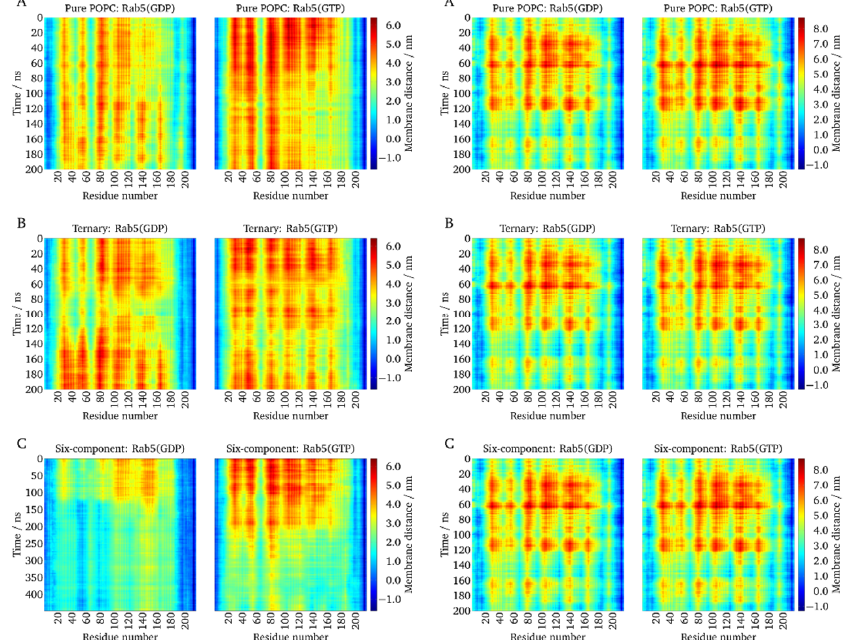
Figure 5. The z-distances between each amino acid residue and the membrane surface were monitored over the molecular dynamics (MD) trajectories. Left: (GG,GG)-Rab5 GDP and GTP; right: (GG)-Rab GDP and GTP.( A ) in pure POPC, ( B ) the ternary mixture, and ( C ) the six-component membrane. (GG,GG)-Rab5 and (GG)-Rab5 forms in both the GDP- and GTP-bound states were